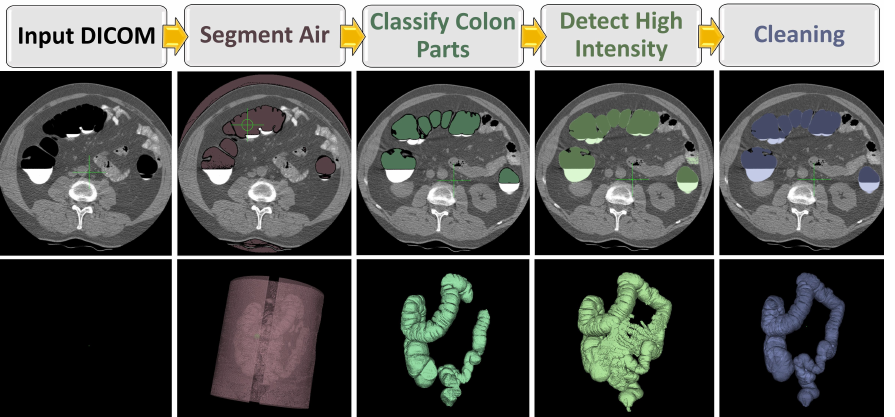
Figure 2. Automatic segmentation pipeline using an MRF